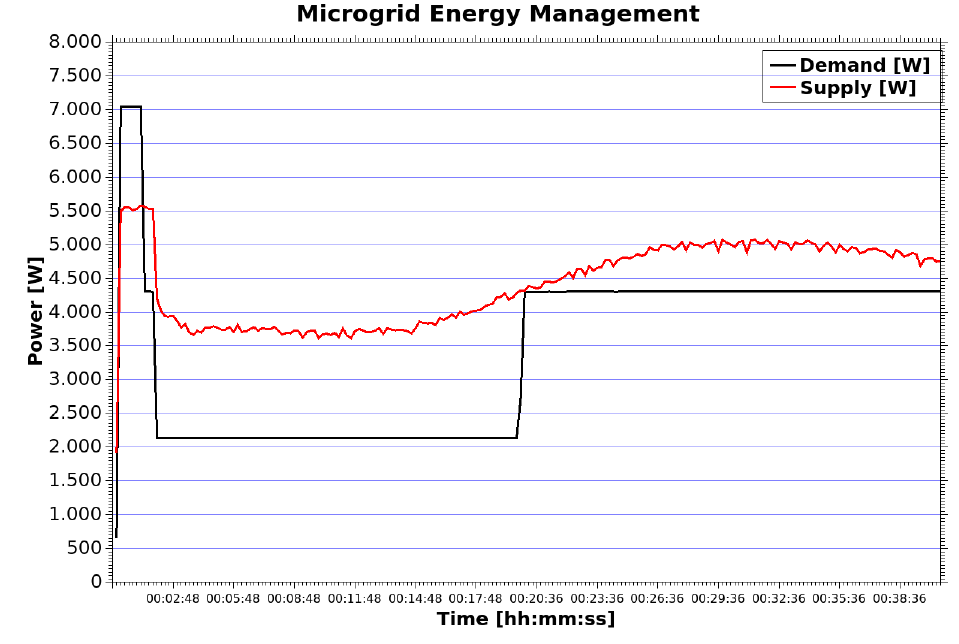
Figure 10. Energy Management for Power Profile Increasing.